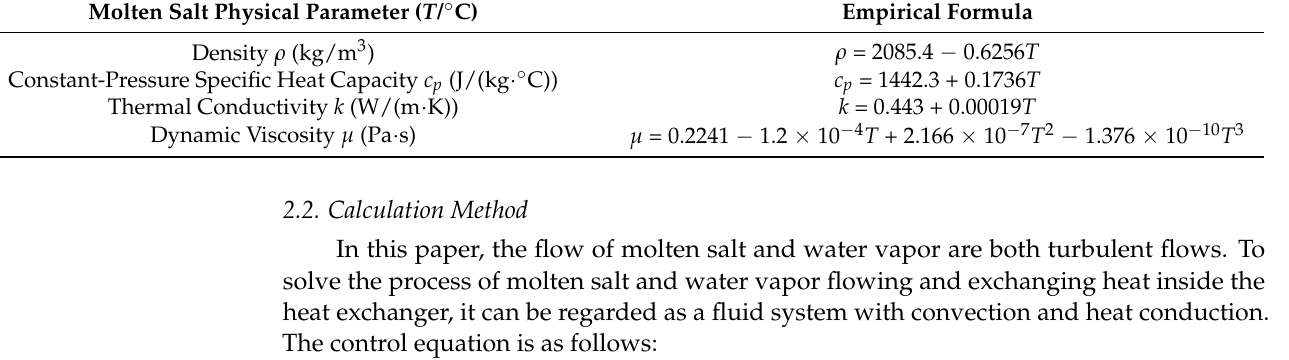
Table 2. Molten salt basic physical property parameters.